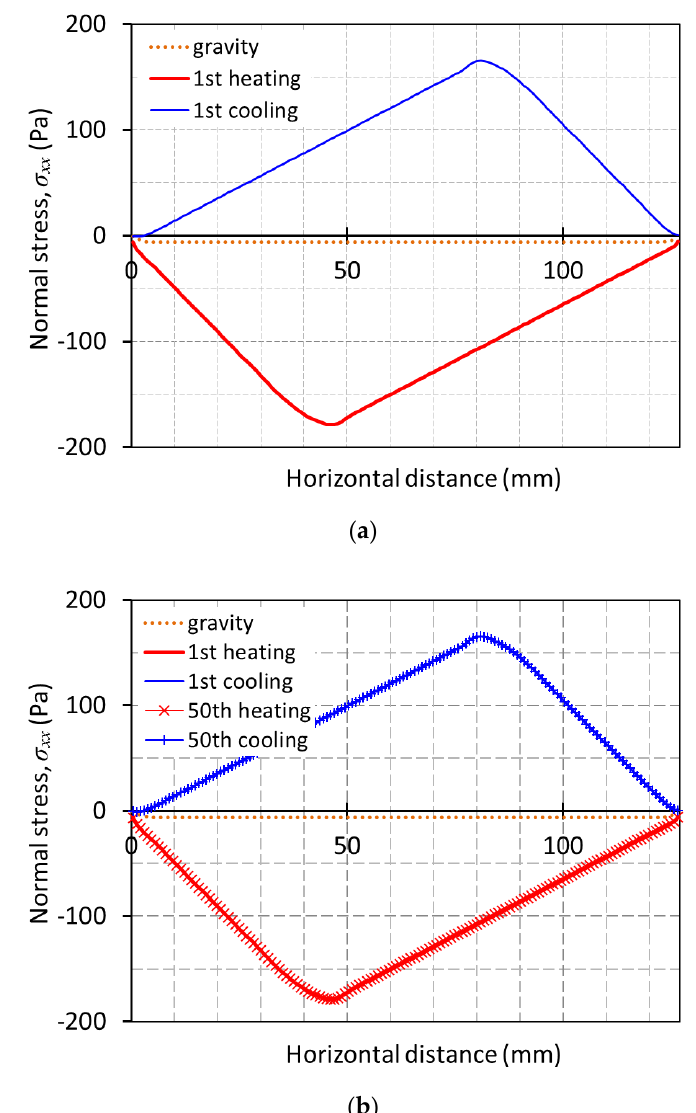
Figure 8. Distributions of normal stress ( 𝜎 𝑥𝑥 ) on the acryl plate. The presented results are based on ∆𝑇 = 23 ℃ in 𝛽 = 5° slope with the parameters in Table 1. ( a ) gravity only (dotted line) and after 1 st heating (red solid line) and cooling (blue solid line) and ( b ) after 50th heating (red solid line with cross) and cooling (blue solid line with tick) in addition to ( a ).